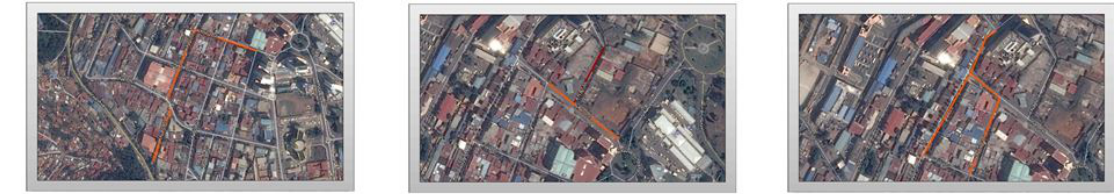
Figure 16. Physical Positions of the optimal Parking(Commercial)